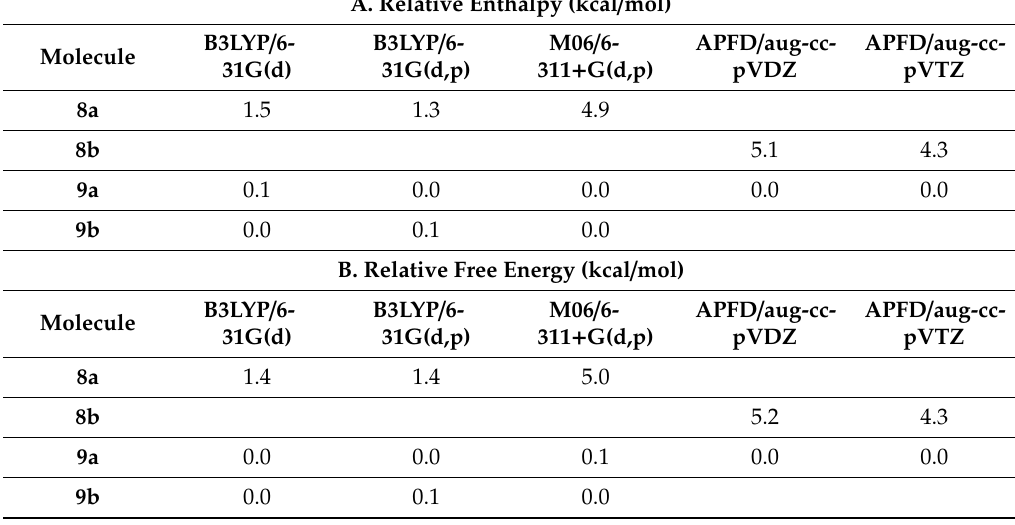
Table 2. Relative enthalpies and free energies of the four stereoisomers of 1-methylazepine N -oxide ( 8a and 8b ) and 7-azanorcaradiene N -oxide ( 9a and 9b ) as a function of computation methodologies (1.000 kcal = 4.184 kJ). In each column the lowest enthalpy or free energy value is set = 0.0 kcal / mol. ( 8a and 8b are easily interconverted as they are similar in enthalpy; the first three calculations favor 8a and the APFD favor 8b ).